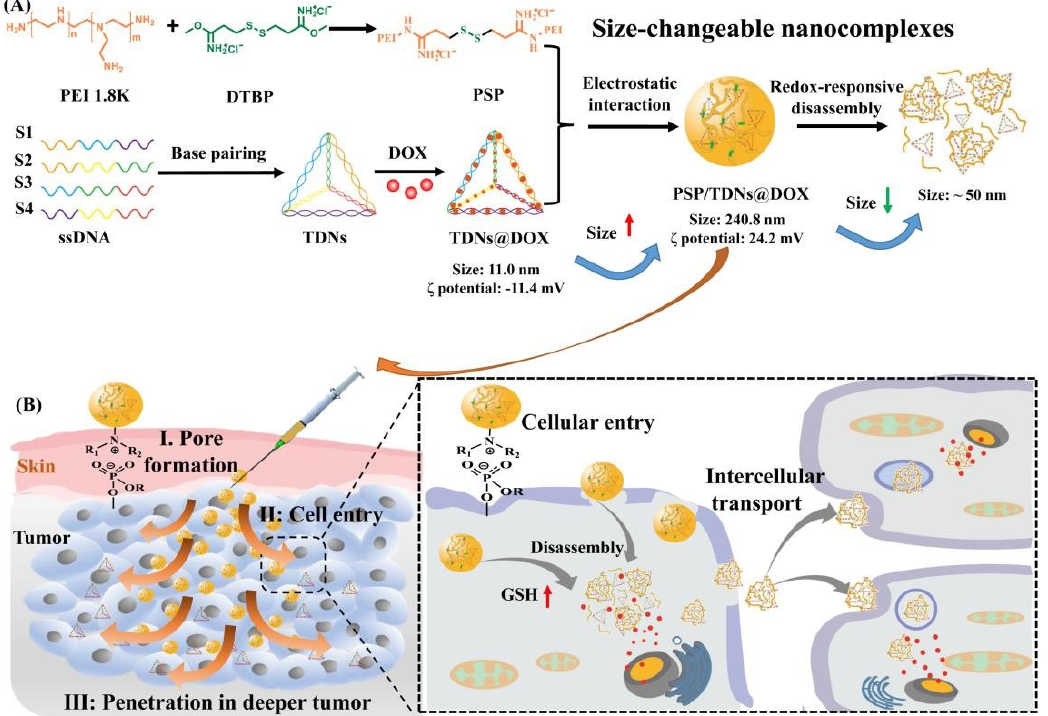
Figure 9. Schematic of the redox-responsive PEI/TDNs/DOX nanocomplexes with membrane- breaking and size-changeable properties for combating MDR tumors. ( A ) Synthesis and size-change mechanism of PSP/TDNs@DOX nanocomplexes. ( B ) Proposed process and underlying mechanism of PSP/TDNs@DOX nanocomplexes overcoming MDR via the formation of pore in plasma mem- branes, promoted cellular entry and cell-to-cell spread, and enhanced penetration in deeper tumor tissue (Reprinted with permission from Ref. [137]. 2021, Jianqin Yan).